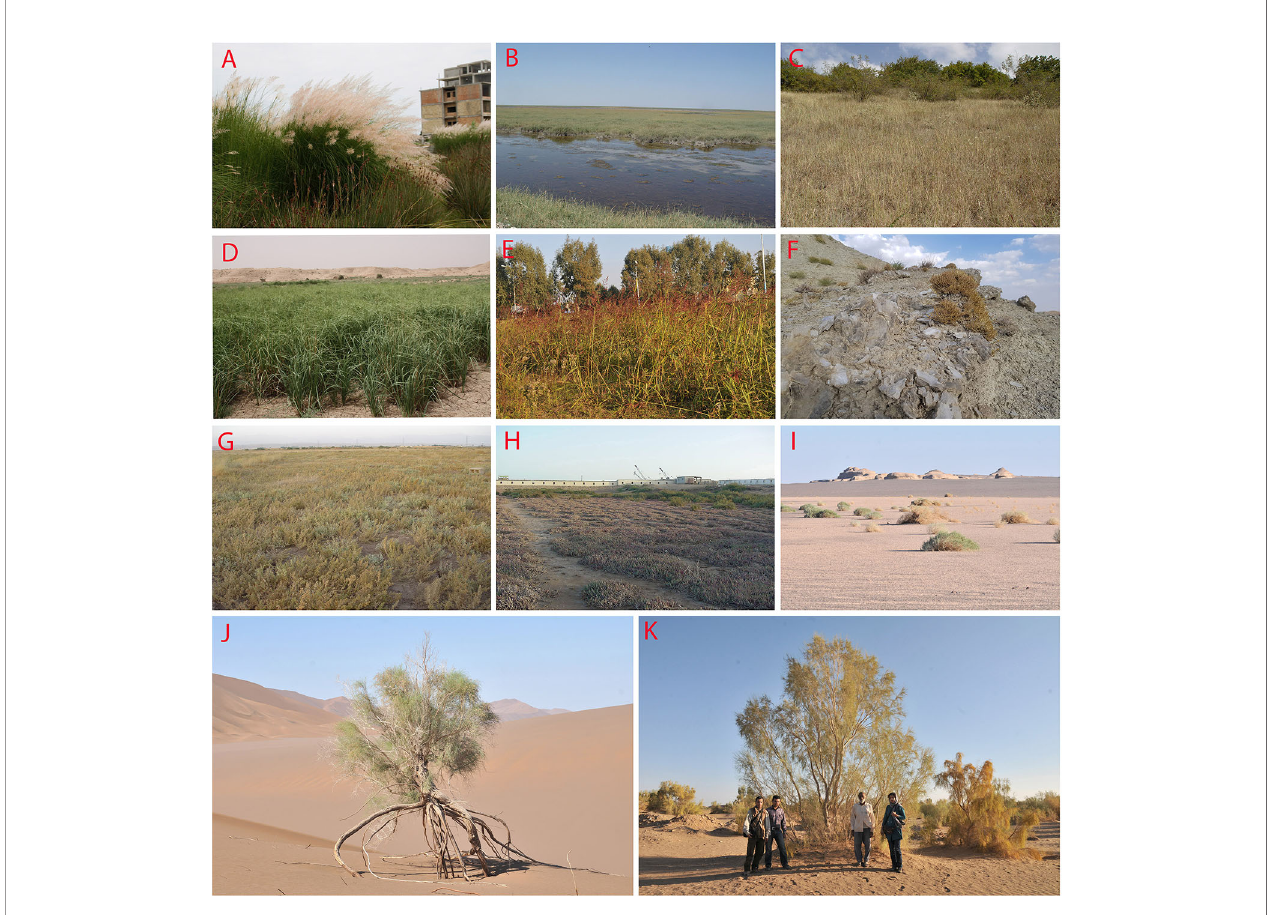
FIGURE 8 | (A – K) Habitats dominated by C 4 vegetation: (A) habitat with high water table in Northeast (NE) Iran, near Caspian Sea, dominated by Saccharum spontaneum L. (B) euhalophytic vegetation of Aeluropus litoralis (Gouan) Parl. community, close to the SE Caspian shores, Turkman Sahra salt fl ats, Iran; (C) C 4 grassland in a temperate forest on rocky S-facing slopes of Golestan National Park, Iran; (D) Desmostachya bipinnata on temporarily fl ooded dry soils in Khuzestan, Southwest (SW) Iran; (E) ruderal vegetation dominated by Sorghum halepense (L.) Pers., SE Caspian coasts, Farahabad, Mazandaran, Iran; (F) gyspsiferous outcrop of Anabasis eugeniae Iljin and Anabasis calcarea (Charif & Aellen) Bokhari & Wendelbo community, NW Iran; (G) euhalophytic community in central Iran, 60 km W Tehran mainly dominated by Bienertia cycloptera Bunge ex Boiss. and Climacoptera turcomanica (Litv.) Botsch. (H) shores of the Makran coast (Pakistan) dominated by Tecticornia indica (Willd.) K. A. Sheph. & Paul G. Wilson, (I) Hammada salicornica (Moq.) Iljin community in Desert Lut, S. Iran; (J) Calligonum amoenum Rech. f. on moving dunes in Lut desert; (K) Haloxylon persicum Bunge shrubland near Mesr Village, c. 40 km E of Jandagh, Dasht-e-Kavir, Iran. All photos H.